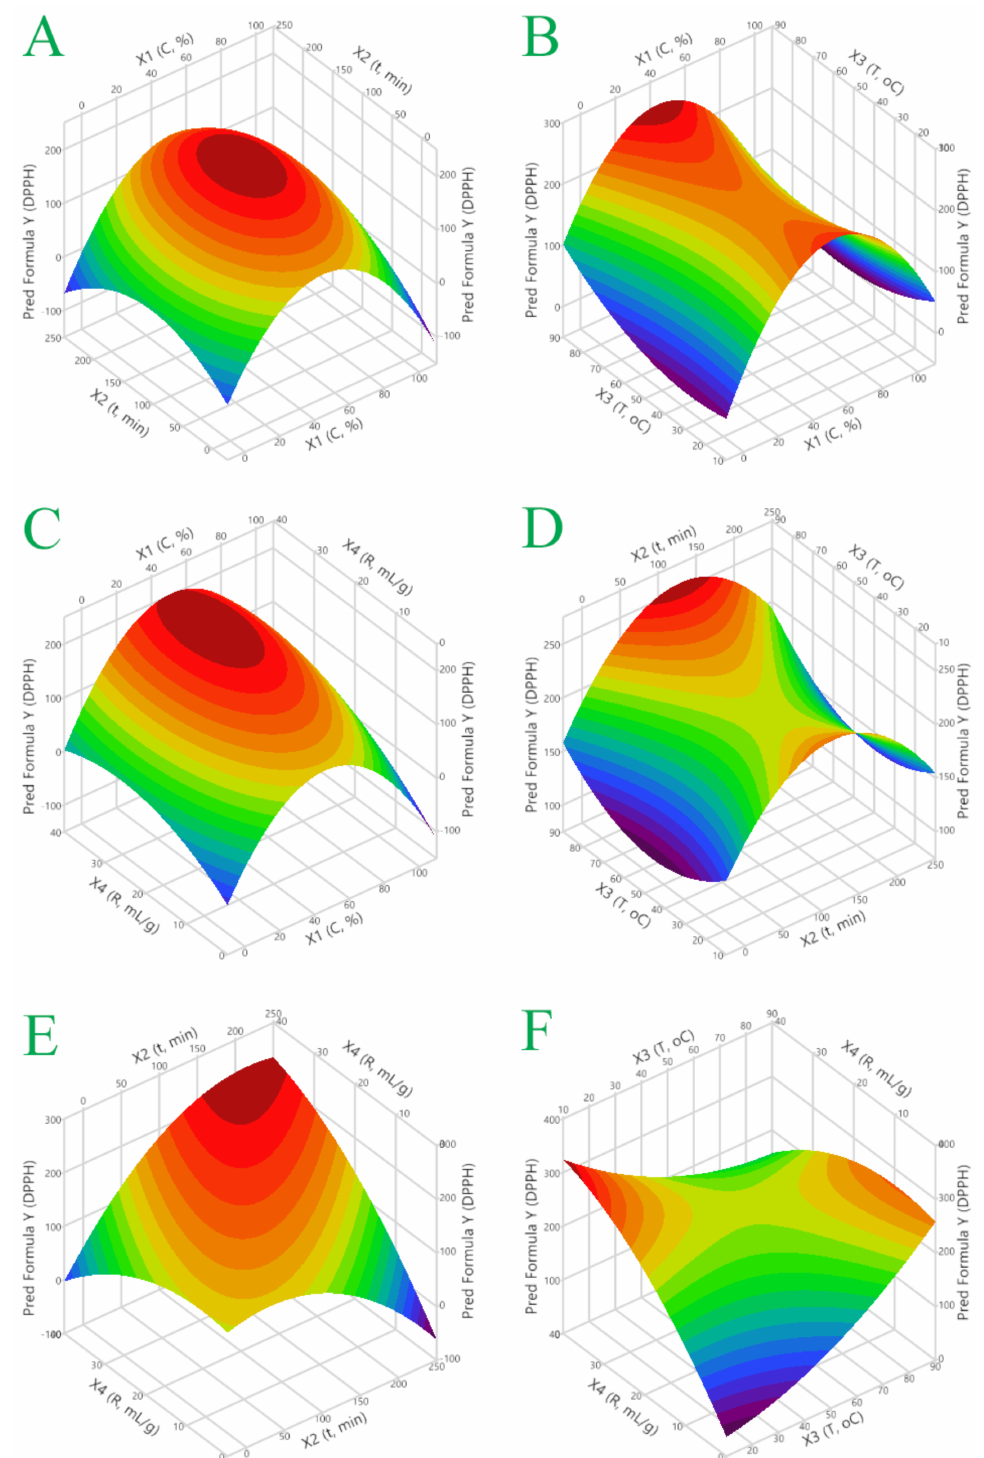
Figure 4. 3D graphs depicting the effect of the process variables considered on the response (DPPH, µ moL DPPH/g), for the optimization of spent coffee grounds extraction performed with hydroethanolic solutions. Plot ( A ), covariation of X 1 ( C , %) and X 2 ( t , min); plot ( B ), covariation of X 1 ( C , %) and X 3 ( T , ◦ C); plot ( C ), covariation of X 1 ( C , %) and X 4 ( R , mL/g); plot ( D ), covariation of X 2 ( t , min) and X 3 ( T , ◦ C); plot ( E ), covariation of X 2 ( t , min) and X 4 ( R , mL/g); plot ( F ), covariation of X 3 ( T , ◦ C) and X 4 ( R ,